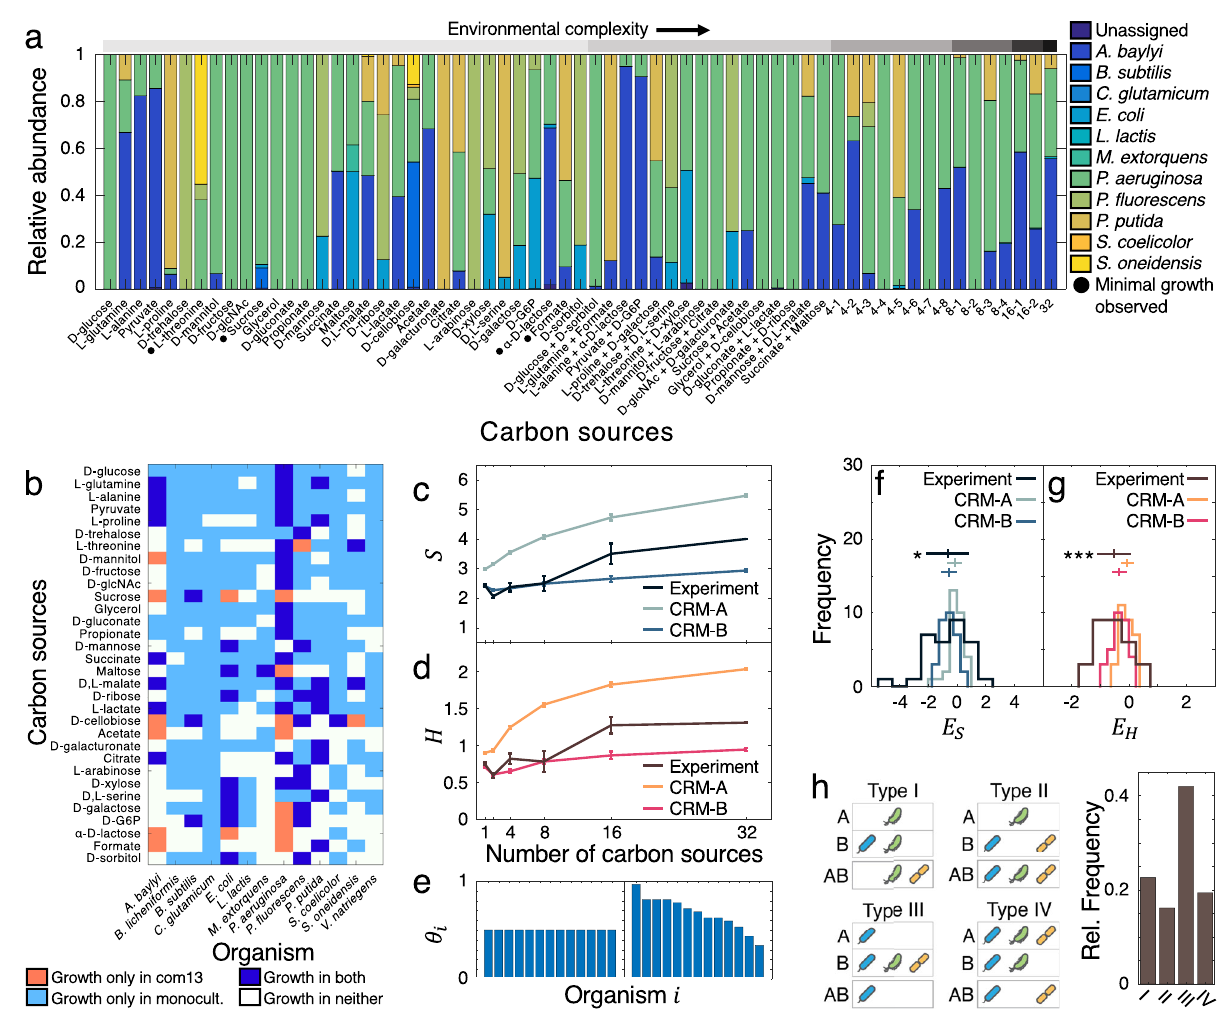
Fig. 3 Endpoint taxonomic properties of 13-species community in up to 32 carbon sources (com13). a Mean species relative abundances across